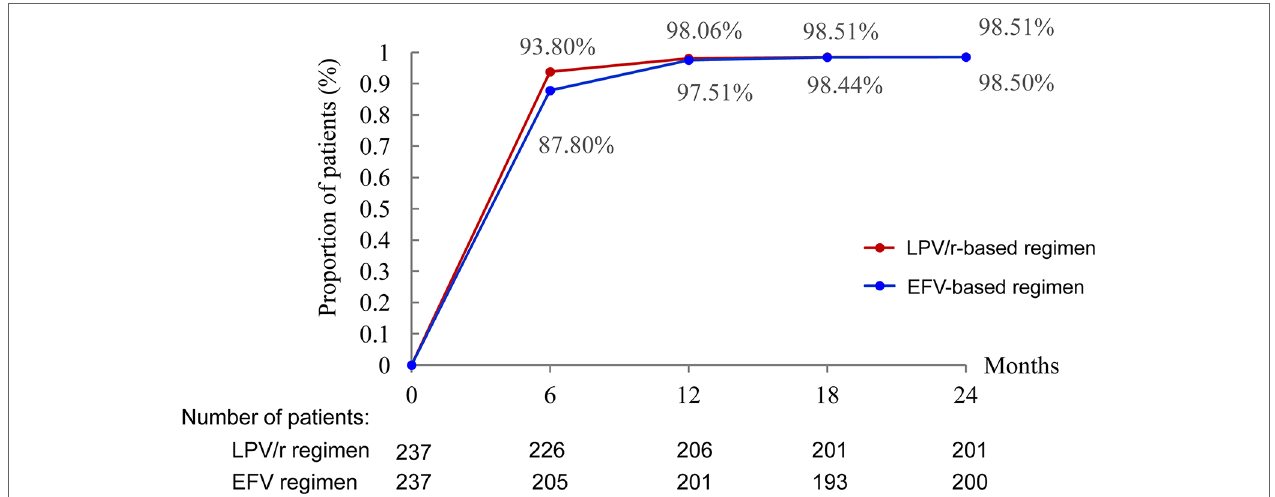
FIgURE 2 | Proportion of patients with HIV RNA <40 copies/ml. * P < 0.05, the difference in the proportion of patients with HIV RNA <40 copies/ml was significant in χ 2 tests.